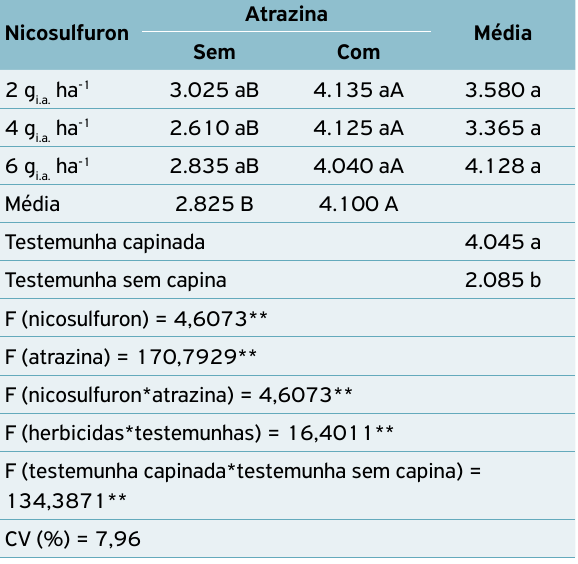
ALVARENGA, R.C.; COBUCCI, T.; KLUTHCOUSKI, J.; WRUCK, F.J.; CRUZ, J. C.; GONTIJO NETO, M.M. A cultura do milho na integração lavoura-pecuária . Sete Lagoas: Embrapa Milho e Sorgo, 2006. (Circular técnica,